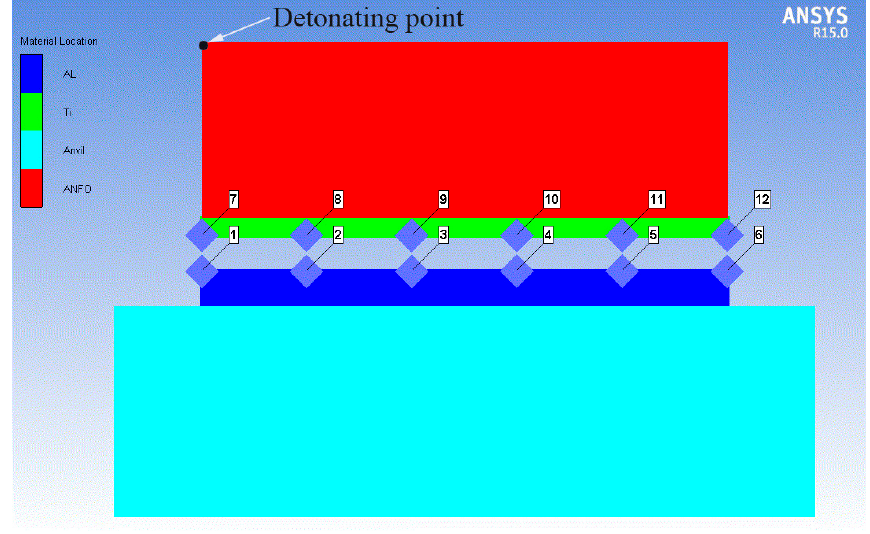
Figure 2. The model of Ti/Al explosive welding in the simulation (ANFO: Ammonium ‐ nitrate/fuel ‐ Figure oil).